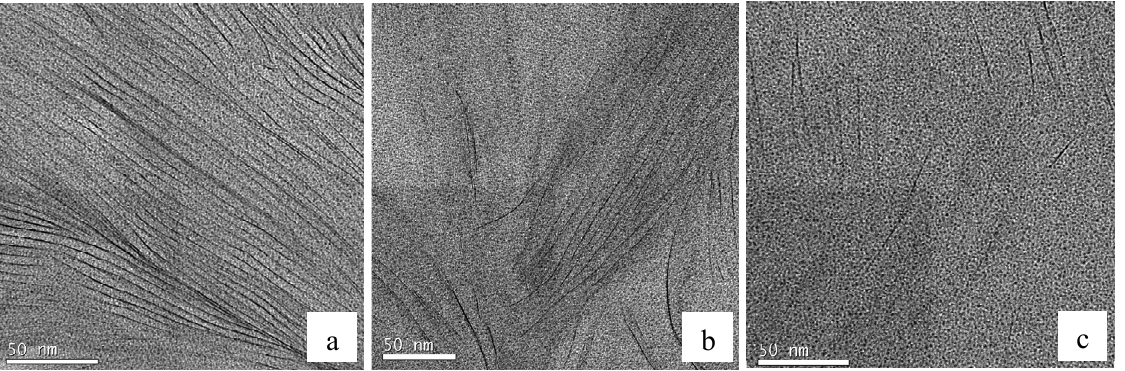
Figure 11. TEM micrographs at high magnification of three different zones within the agglomerate of Figure 10a for a DGEBA nanocomposite with 2 wt% clay and cured with Lupasol